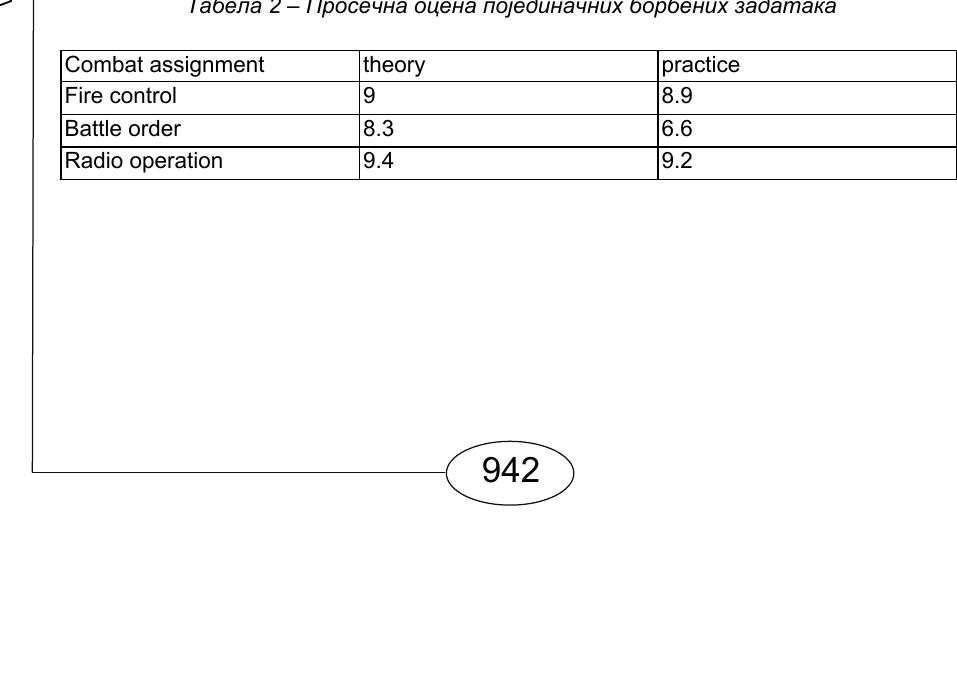
Table 2 – Average Assessment of Individual Combat